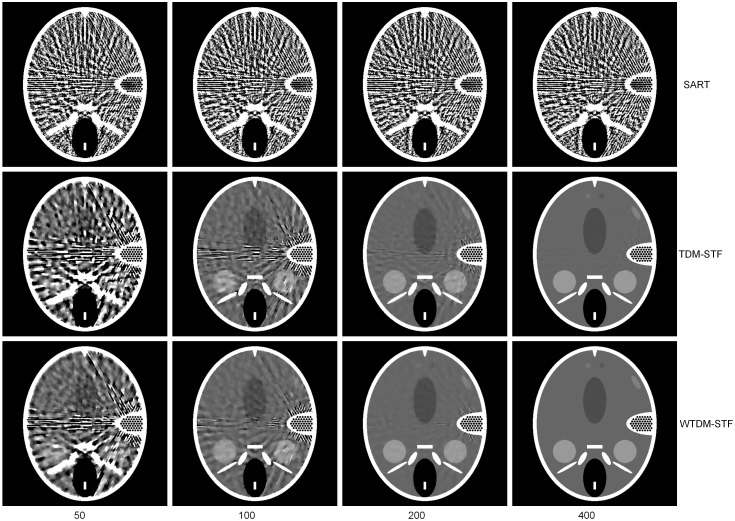
Images reconstructed by SART (first row), TDM-STF (second row) and WTDM-STF (third row) algorithms after 50, 100, 200, 400 iterations using noise-free projections, respectively.The gray scale window is set to [1.03, 1.08].